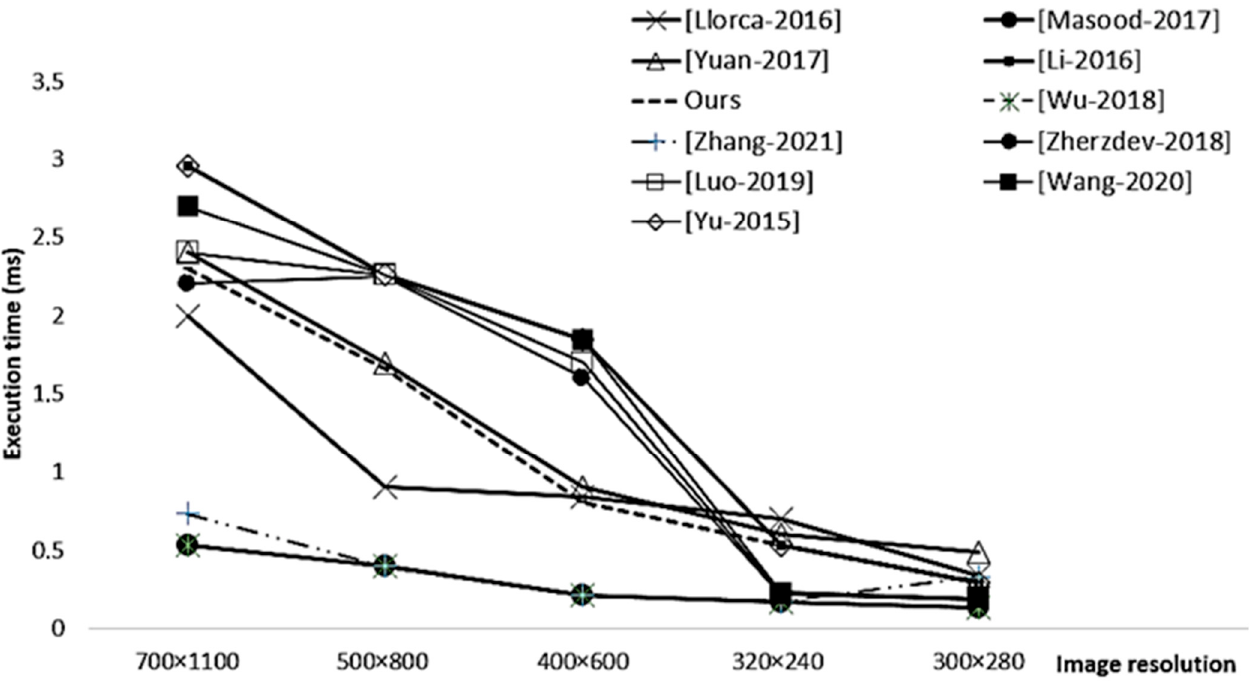
Figure 9. Computational complexity